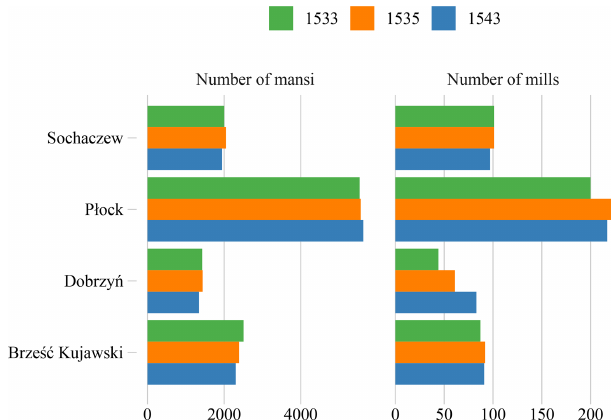
Figure 2. Changes in cultivated land based on surviving tax sum- maries from 1533, 1535 and 1543. Sources: Archival sources AS 1– AS